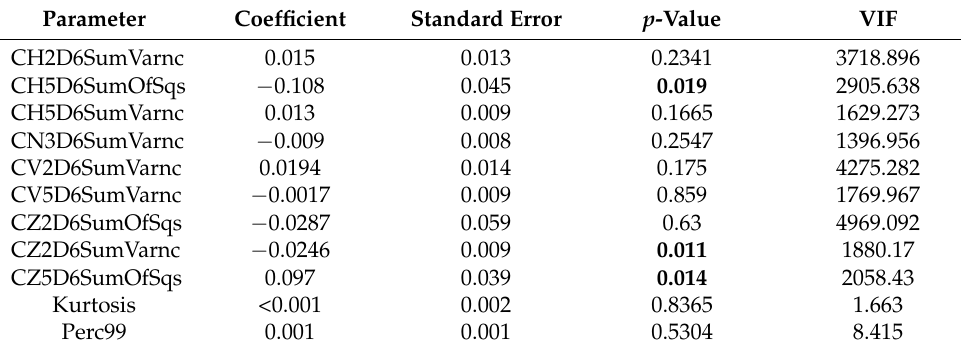
Table 2. Multivariate analysis results showing the parameters independently associated with the presence of malignant lesions. Bold values are statistically significant ( p < 0.05). VIF, variance inflation